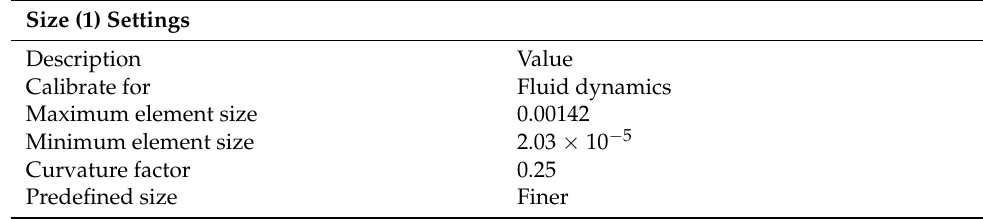
Table 2. The setting of mesh cells.